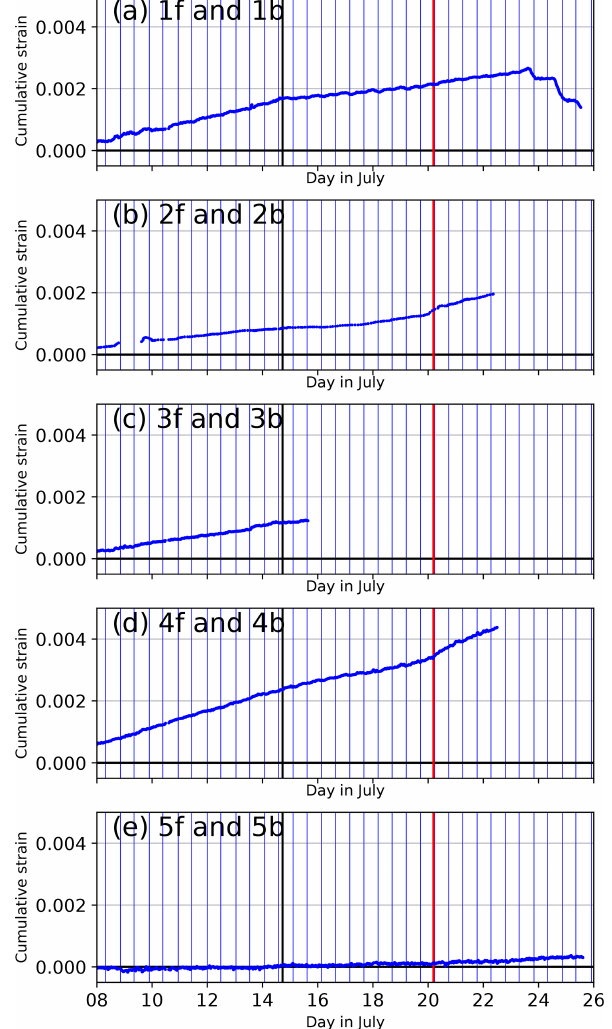
Figure 8. Cumulative strain time series for each along-flow station pair ( a–e ; 1h moving average), timing of high tide (vertical blue lines), speed-up (black lines), and the 20 July 2019 calving event (red lines; GPS positions in Fig. 3c). Increasing cumulative strain means stretching occurs at the surface, whereas surface compres- sion gives decreasing cumulative strain.